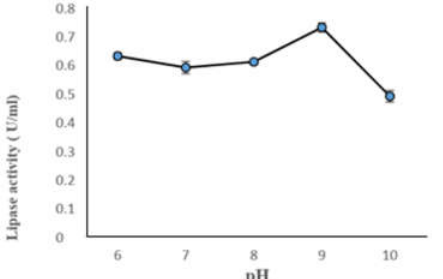
Fig. 4. Effect of pH on lipase activity producing by AR11 in a medium containing 5 % NaCl. Results represent the means of three separate experiments, and bars indicate ±1 standard deviation.